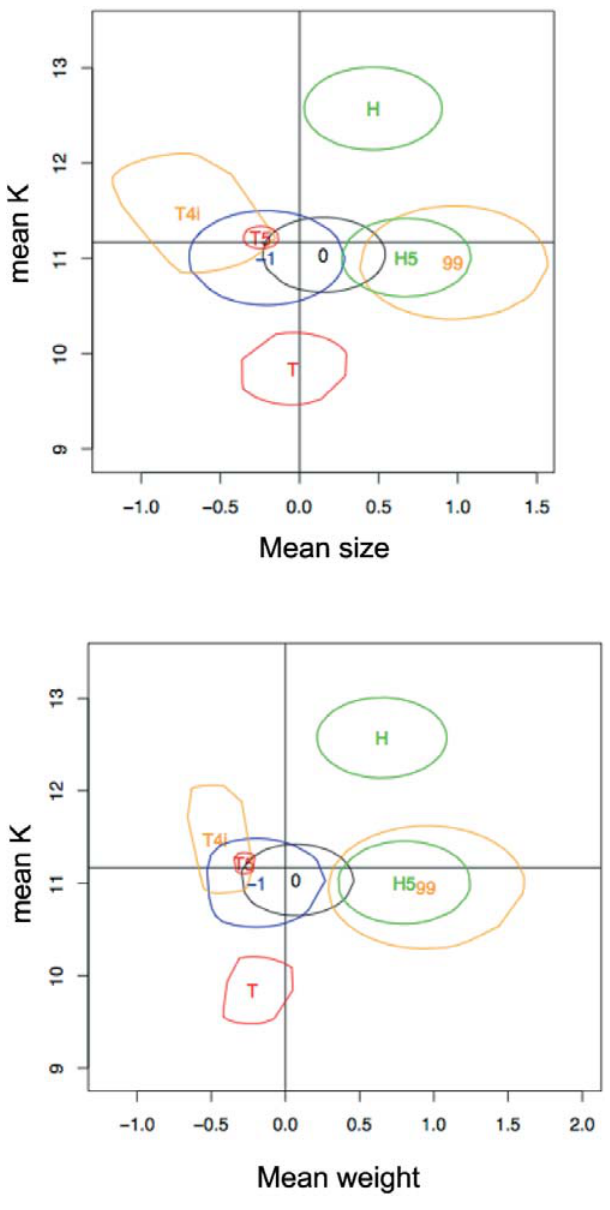
Figure 5. COEFFICIENT OF CONDITION AND CONFIDENCE SURFACES. Confidence surfaces for mean K-size (a) and mean K-weight (b) plots, based on non-parametric bootstrap (1000 replicates). The circles correspond to 95% of bootstrapped values. H and T correspond to C. n. nasus and C. t. toxostoma , respectively, in the reference populations. The other classes are those of the hybrid zone (T5; H5; -1=un- derrepresented hybrid combinations; 0=hybrid combinations found in the expected proportions; 99=overrepresented hybrid combinations; T4i=the only hybrid combination for which sufficient specimens were obtained for comparison alone, without pooling). The variance of K is very significantly different (Bartlett B=63.7; p =10 2 10 ) between classes.